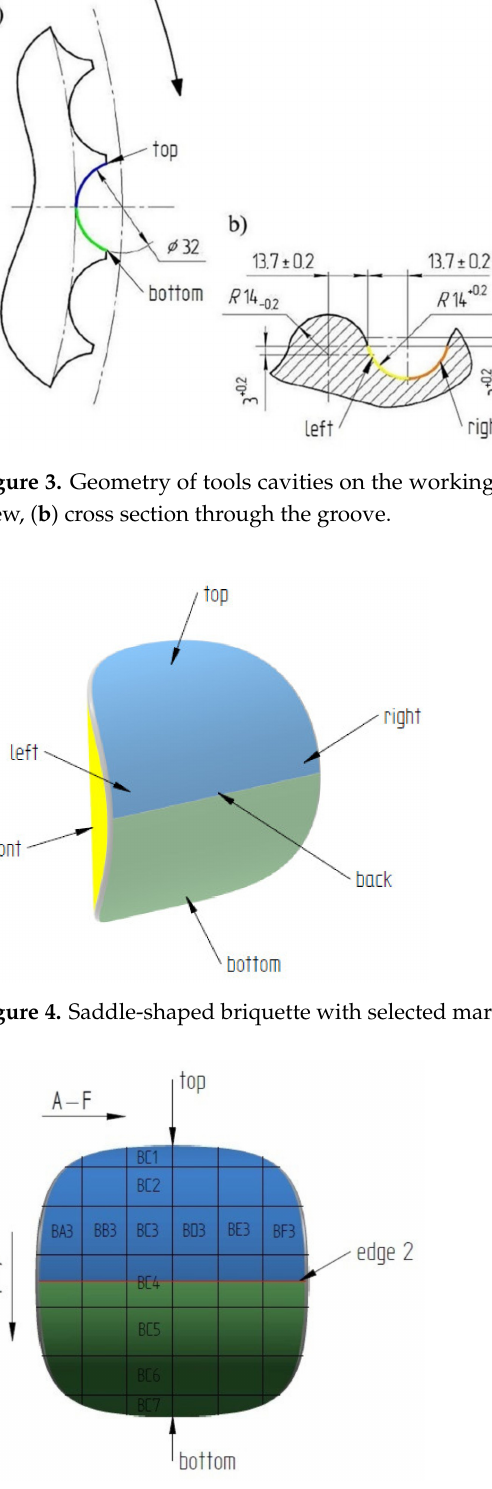
Figure 5. Back surface with the way of notification of designated